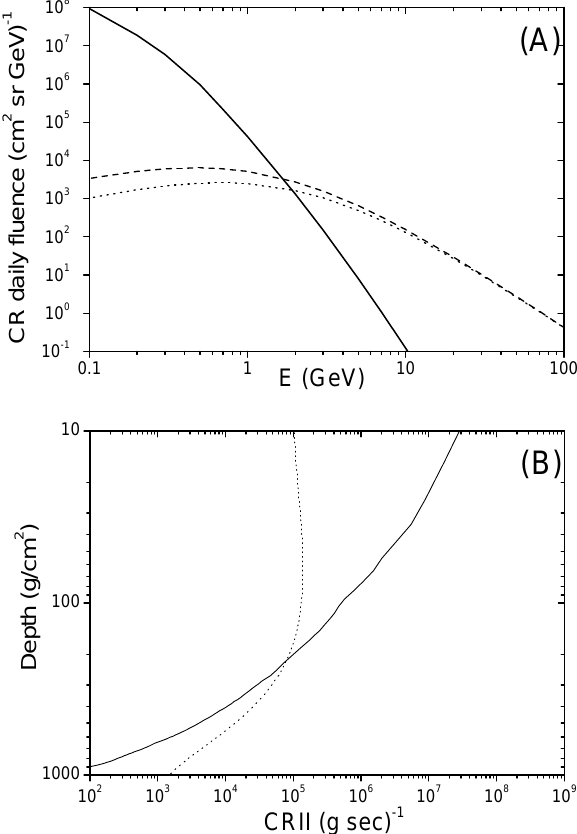
Fig. 2. Input proton spectra and the resulting atmospheric ionization for the event of 2005-Jan-20. A) Differential fluence of solar protons from the 2005-Jan-20 event and the daily fluence of GCR protons for the day of 2005-Jan-20, including the effect of the Forbush decrease (dotted line). The dashed curve depicts the average GCR proton fluence for January 2005. B) The vertical profile of the daily averaged CRII in the polar region from GCR (dotted curve) and SEP (solid curve) separately, for the day of 2005-Jan-20.